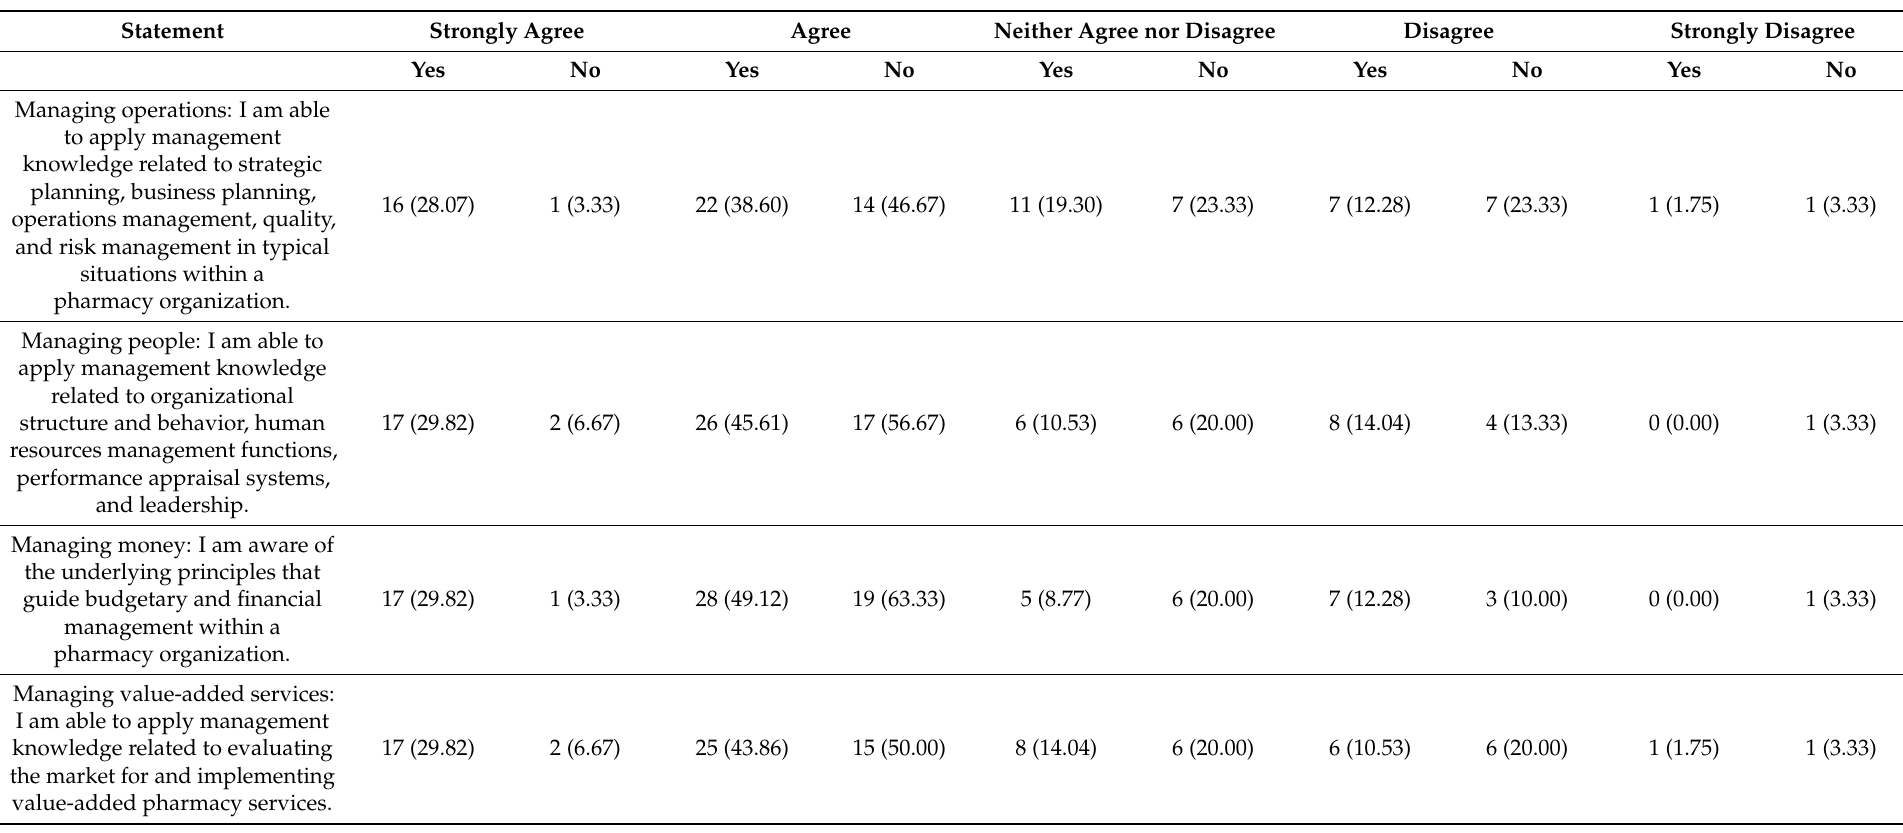
Table A6. Ability to use pharmacy financial management knowledge in practice by business related courses prior to pharmacy school (N = 139).